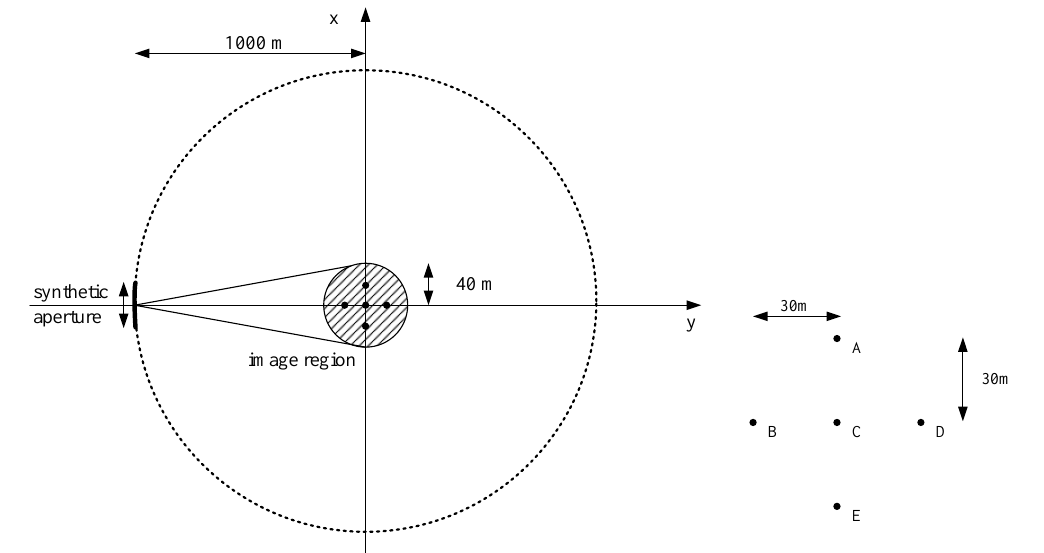
Figure 17. Collection geometry and scene geometry.